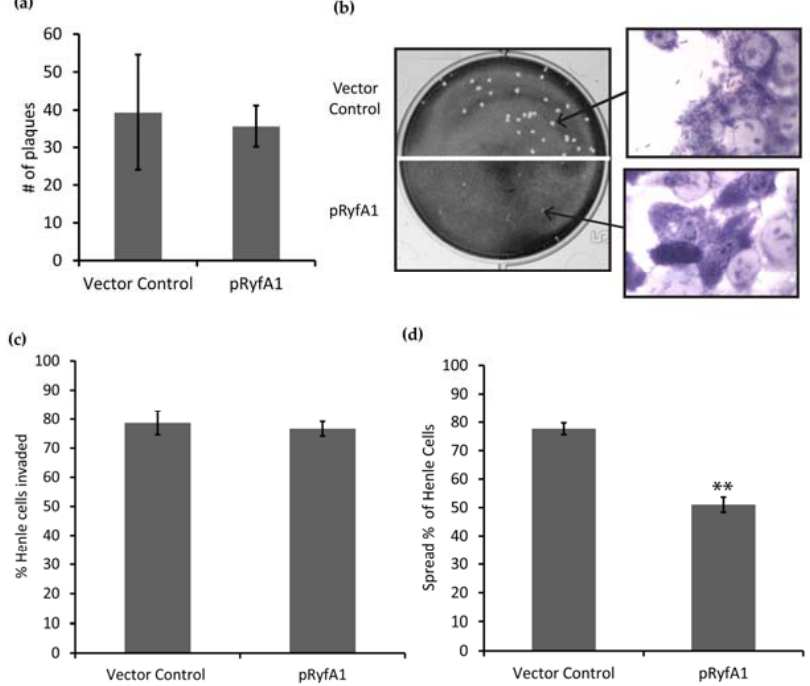
Figure 6. RyfA1 overproduction inhibits cell to cell spread by S. dysenteriae . ( a ) No significant difference was observed in the number of plaques formed between the vector control and pRyfA1. ( b ) Representative image of plaques formed by S. dysenteriae carrying either the pQE2 vector control or the ryfA1 producing plasmid pRyfA1 cultured and maintained under inducing conditions. The magnified image is of Henle cells (larger light purple cells) and bacterial cells (dark purple smaller cells) surrounding the plaque formed by the indicated strain. Quantification of the ability of S. dysenteriae carrying the RyfA1-producing plasmid pRyfA1 or the vector control to invade Henle cells ( c ) and to spread between Henle cells within a subconfluent monolayer ( d ). All assays were carried out following growth of the indicated strain in the presence of IPTG, and the inducer was maintained throughout the analyses. Data presented in panels ( a ), ( c ), and ( d ) are the average of biological triplicate analyses and error bars represent one standard deviation. ** denotes a statistically significant difference with p < 0.001.